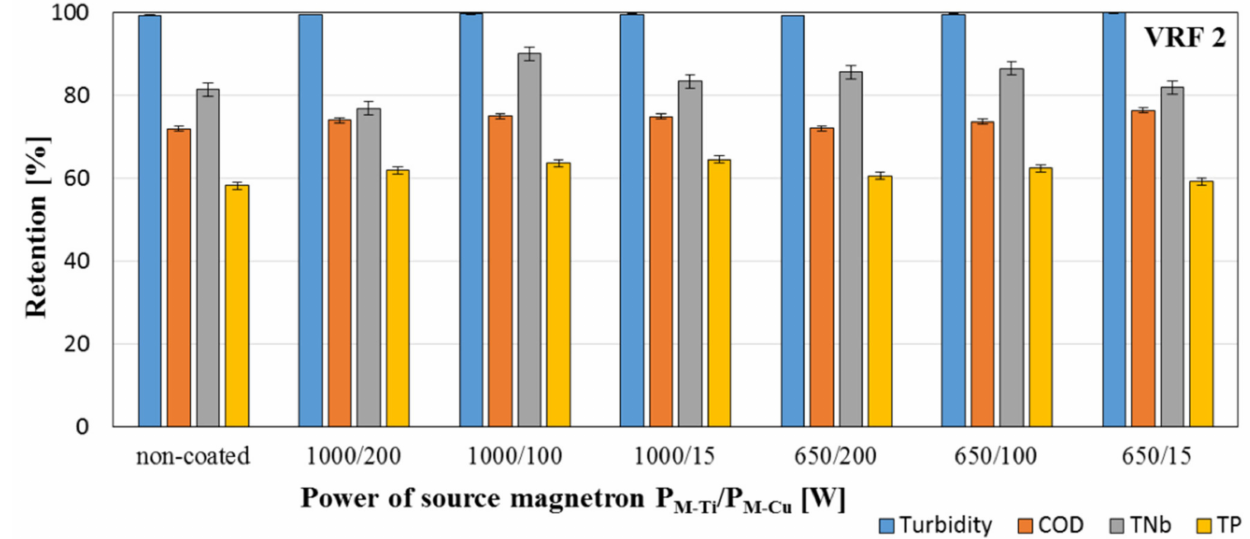
Figure 13. Retention coefficients of individual parameters of model dairy wastewater obtained after a 2-fold reduction in the volume of the feed in the filtration process using a non-coated membrane and membranes with deposited TiO 2 + CuO coatings.